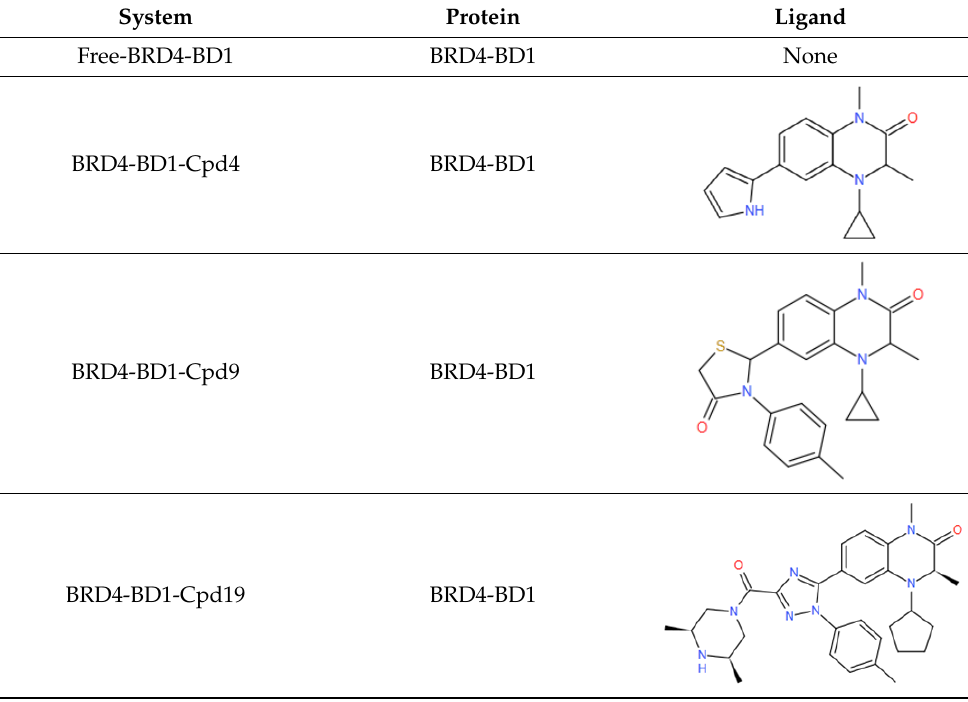
Table 1. Four systems in 150 ns molecular dynamics